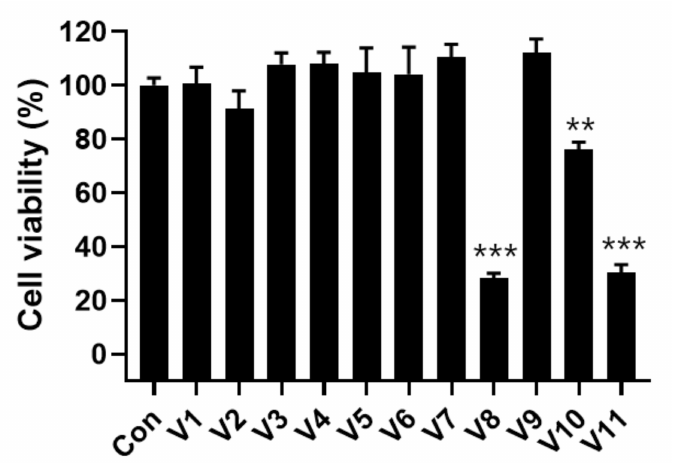
Figure 2. Cytotoxicity of velutin derivatives in the B16F10 melanoma cells. B16F10 cells were treated with 0.1% DMSO as vehicle, or with 20 µ M of each derivative, for 24 h. Cell viability was determined by the MTT assay, as described in the Experimental Section. Data are expressed as the mean ± SD of three independent experiments (** p < 0.005, *** p < 0.001 compared to the control